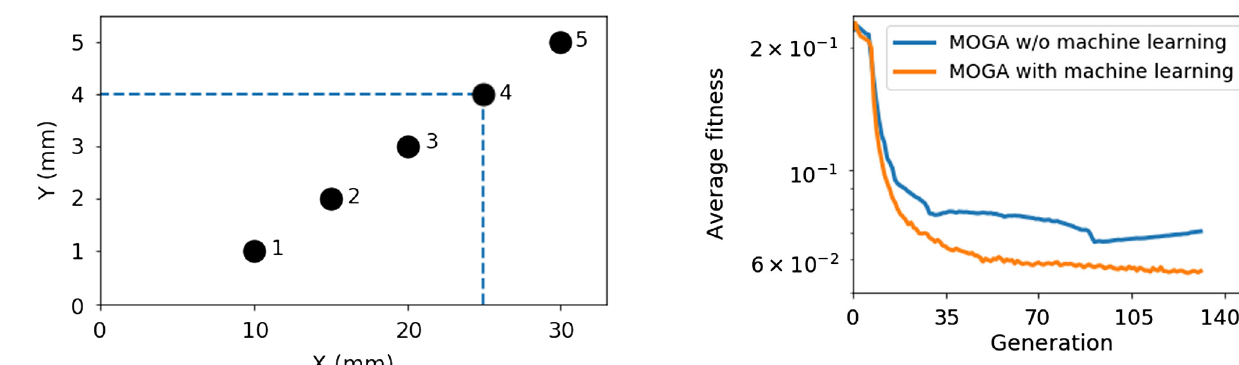
FIG. 3. Five initial particle coordinates in the x − y plane with their conjugate momenta p x;y ¼ 0 used for tracking. The turn-by- turn data are used to evaluate the spread of their linear actions. The dashed line is the size of the desired dynamic aperture. The 5th particle is chosen beyond the desired dynamic aperture in order to obtain a safe margin. The choice of the initial coordinates is not arbitrary. It may depend on the local optics functions, and physical aperture, etc.